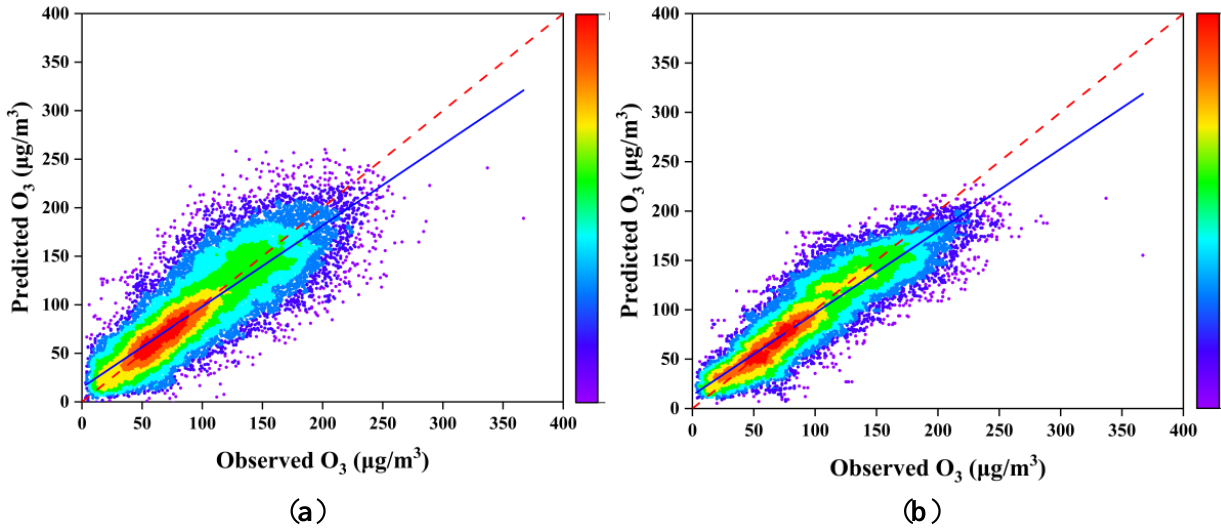
Figure 5. Scatter plot of observed and simulated daily maximum 8-h average O 3 concentration in the BTH region based on LOOCV ( a ) and leave-city-out validation ( b ). The dashed line is the 1:1 line, while the solid line is the linear regression. Table 1. LOOCV and leave-city-out validation results of BME estimations of daily O 3 concentrations. Validation